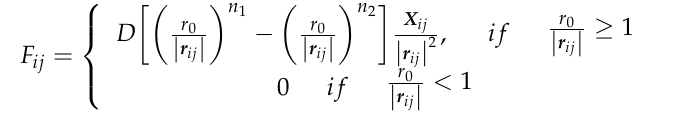
Figure 3. Schematic illustration of the solid boundary treatment.